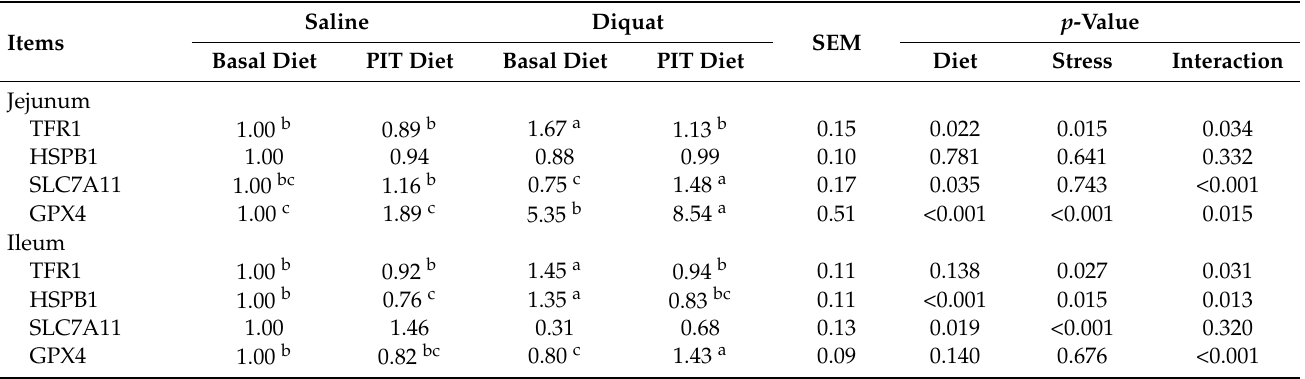
Table 7. The relative gene expressions of ferroptosis-related signals of the piglets fed polyphenols sourced from Ilex latifolia Thunb. (PIT) diets under oxidative